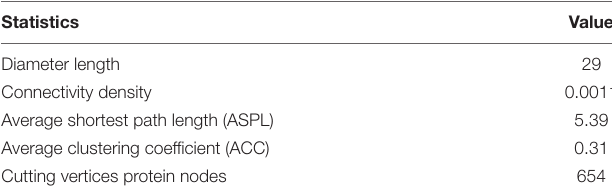
TABLE 1 | Dual-layered network